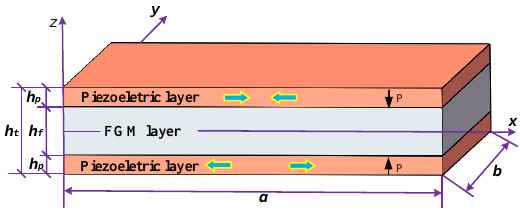
Figure 1. Structure diagram of the PFGP.